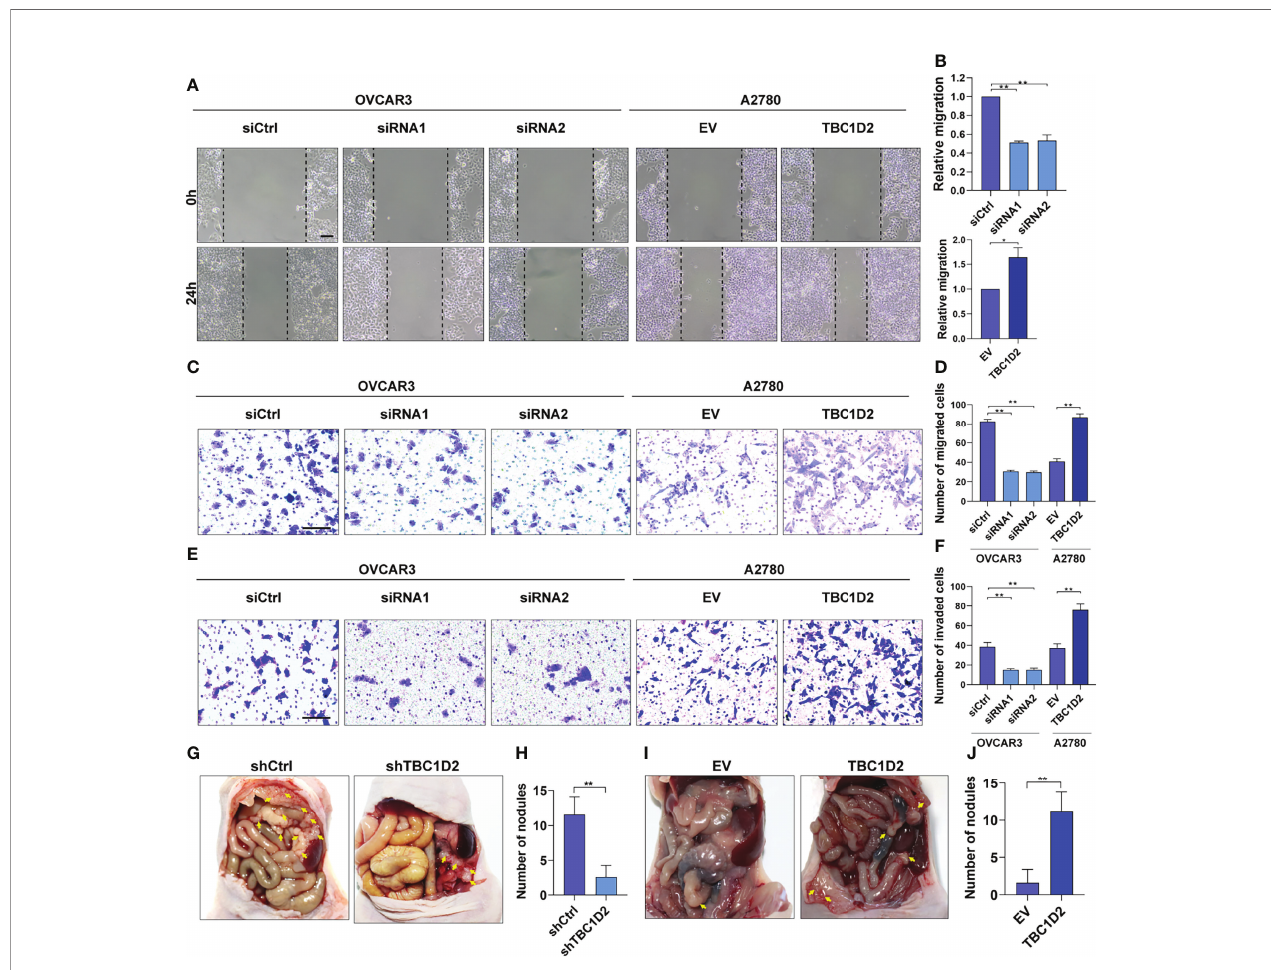
FIGURE 3 | TBC1D2 promotes the migration and invasion of OC cells in vitro and tumor metastasis in vivo . (A, B) Representative images and analysis of wound healing assays in OVCAR3 and A2780 cells treated as indicated. Scale bars, 100 m m. (C, D) Representative images and analysis of transwell migration assays in OVCAR3 and A2780 cells treated as indicated. Scale bars, 100 m m. (E, F) Representative images and analysis of transwell-Matrigel invasion assays in OVCAR3 and A2780 cells treated as indicated. siRNA1 or siRNA2, siRNA against TBC1D2; siCtrl, control siRNA; EV, empty vector; TBC1D2, overexpression vector encoding TBC1D2. Scale bars, 100 m m. (G – J) Representative images of intraperitoneal metastases and number of metastatic nodules in each group were shown and analyzed; n = 5/group. Two-tailed Student ’ s t tests were used to determine the signi fi cance of differences between two groups; data are represented as mean ± SEM. *P<0.05,